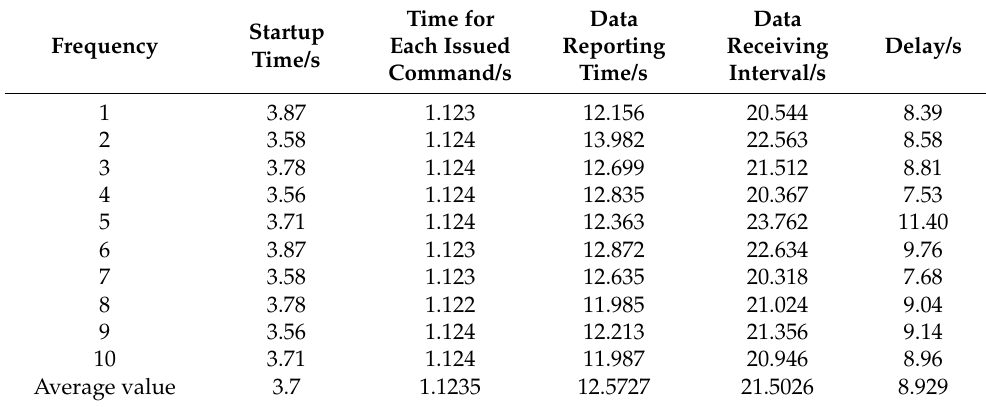
Table 7. Long-range test results (1000–1500 m).